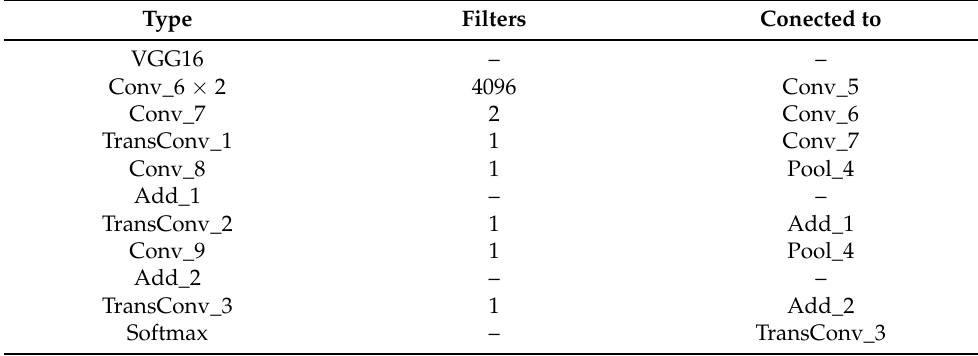
Table 3. Layer description of the VGG16+FCN8.